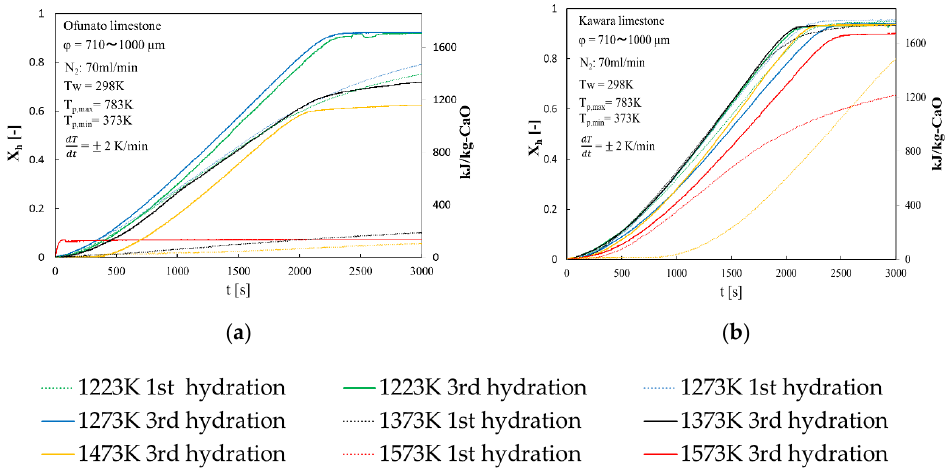
Figure 5. Hydration conversion after decarbonization in muffle furnace. ( a ) Ofunato CaO ( b ) Kawara CaO.